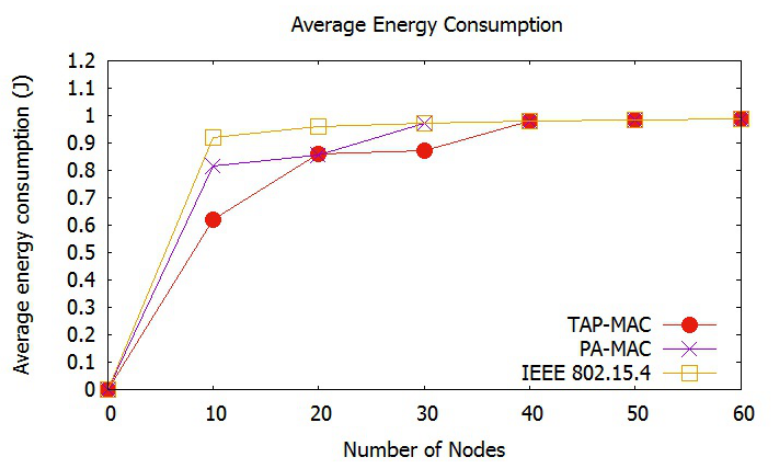
Figure 10. Scenario 1: Average energy